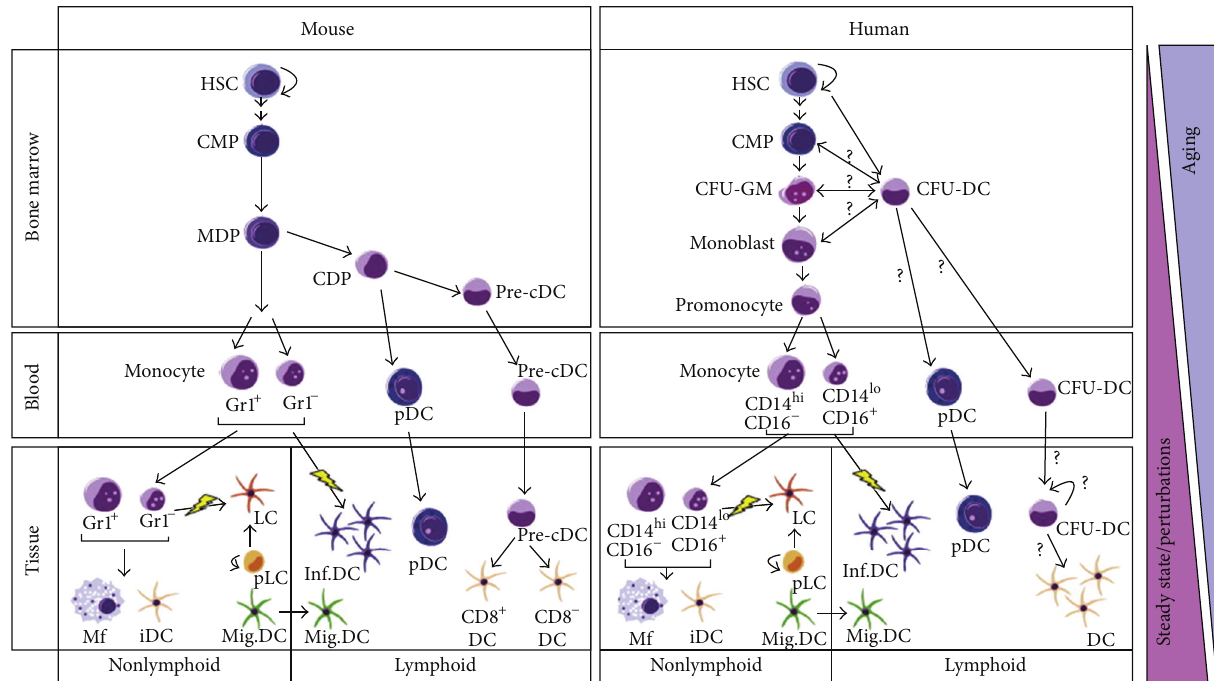
Figure 1: Mononuclear phagocyte differentiation in mouse and human. Hematopoiesis in mouse and human begins from the hematopoietic stem cells (HSCs). The HSCs are self-renewing with clonogenic and multipotent features, giving rise to all blood and tissue-resident immune cells. A very small number of HSCs generate immune cells de novo through a multistep differentiation process passing through multilineage progenitors first and to committed progenitors later. All of this process is strictly regulated according to physiological requirements, be it in the steady state or in response to external perturbations, such as infection. Aging also profoundly affects the function of the immune system. The phenomenon is attributable mainly to changes in the HSC compartment that probably gradually reduces its capacity for self-renewal, leading to a progressive reduction in the numbers of immune cells. Myeloid differentiation starts from a common myeloid progenitor (CMP) in the bone marrow. In the mouse, the destiny of CMP is better characterized compared to that of the human counterpart. The CMP generates macrophage-(Mf-) dendritic cell (DC) precursors (MDPs), which are considered the direct progenitor of Gr1 + and Gr1 − monocytes in the blood. Besides monocytes, the MDP differentiates into the common DC precursor (CDP), which in turn generates plasmacytoid DC (pDC) and progenitors for conventional DC (pre-cDC). pDC and myeloid DC diverge at the CDP stage. Pre-cDCs migrate out of the BM through the blood circulation into secondary lymphoid tissues (spleen and lymph nodes), where they replenish both CD8 + and CD8 − DC in the tissues. In humans, CMPs differentiate to granulocyte-macrophage (CFU-GM) precursor, which give rise to monocytes (CD14 hi CD16 − and CD14 lo CD16 + ) through subsequent differentiation steps, monoblast first, followed by promonocyte. A DC precursor (CFU-DC) derived from CD34 + HSC with unique differentiation potential towards DC has been identified in bone marrow of the mouse, suggesting that a DC progenitor might exist in humans. Blood monocytes (Gr1 + and Gr1 − in mouse, CD14 hi CD16 − and CD14 lo CD16 + in humans) migrate to nonlymphoid tissues and generate macrophages (Mfs) and interstitial DC (iDC). In the presence of environmental perturbation in vivo or of cytokines in vitro , Gr1 + or Gr1 − monocytes in mice and CD16 + or CD16 − monocytes in humans differentiate into Langerhans cells (LCs) in the epidermis, as well as inflammatory DC (Inf.DC). LCs are generated by a dermal long-term precursor (pLC) in the steady state. Finally, migratory DC (Mig.DC) moves between nonlymphoid and lymphoid